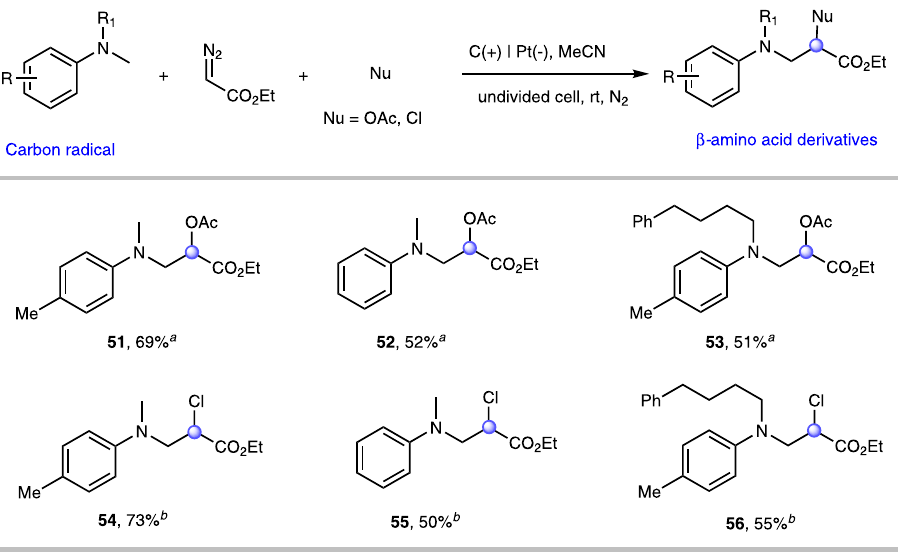
Fig. 3 | Scope of substrates of carbon radicals. Conditions: a aniline (0.5mmol), ethyldiazoacetate(0.3mmol),HOAc(0.5mL), n Bu 4 NBF 4 (1.0mmol),MeCN(6mL), carbon rod as anode, platinum as cathode, undivided cell, constant current=10 mA, rt, N 2 , 2h; isolated yield. b aniline (0.7mmol), ethyl diazoacetate (0.3mmol),